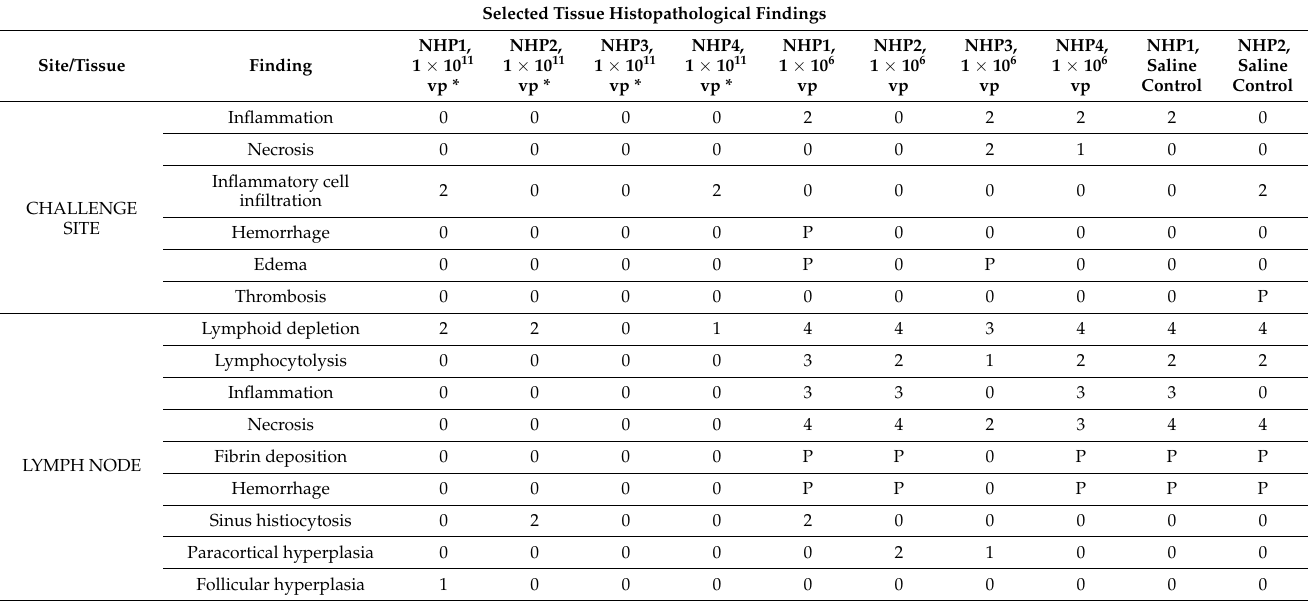
Table 3. Histopathological findings and scores for key tissues in vaccinated and control animals. Selected Tissue Histopathological